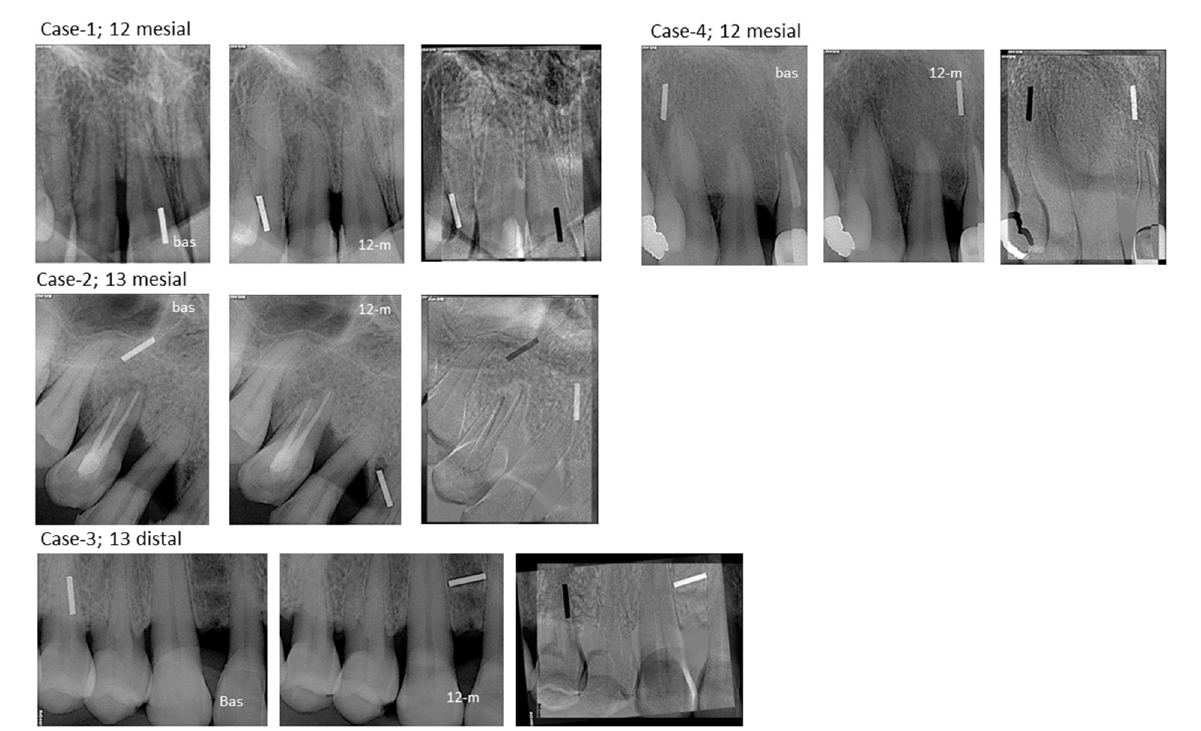
FIGURE6 Radiographic assessment of cases #1–4. Regions in which both radiographic images had the same intensity are shown as gray on the digital subtractive image. Regions in which the later radiograph (12-m) is more radiolucent than the earlier one (baseline) are demonstrated as dark regions on the digital subtractive image, whereas regions in which the later radiograph is more radio-opaque than the earlier one, i.e., regions that correspond to bone apposition, are presented as white regions. White regions are evident on the alveolar crest of all